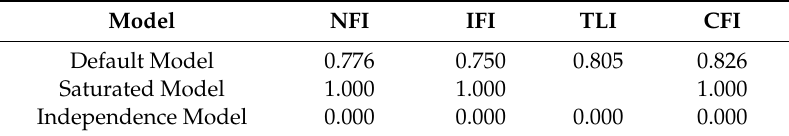
Table 5. Comparative fit index and Tucker-Lewis index tests.